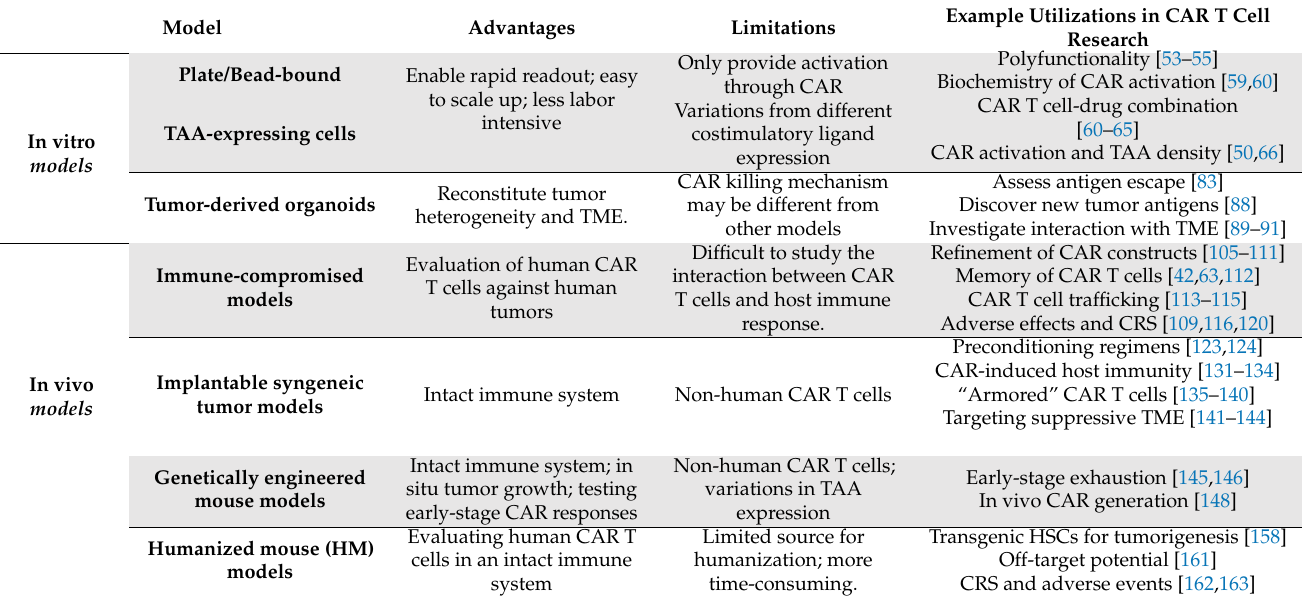
Table 1. Summary of the models for CAR T cell functional